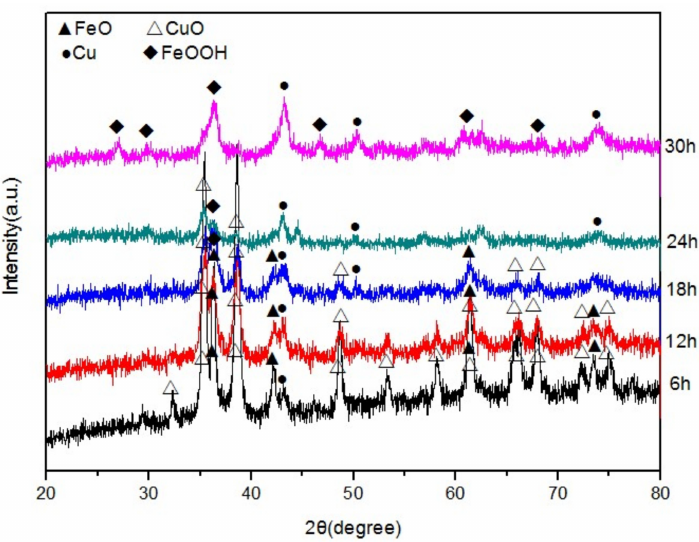
Figure 1. X-ray diffraction (XRD) patterns of products appearing in the process at different